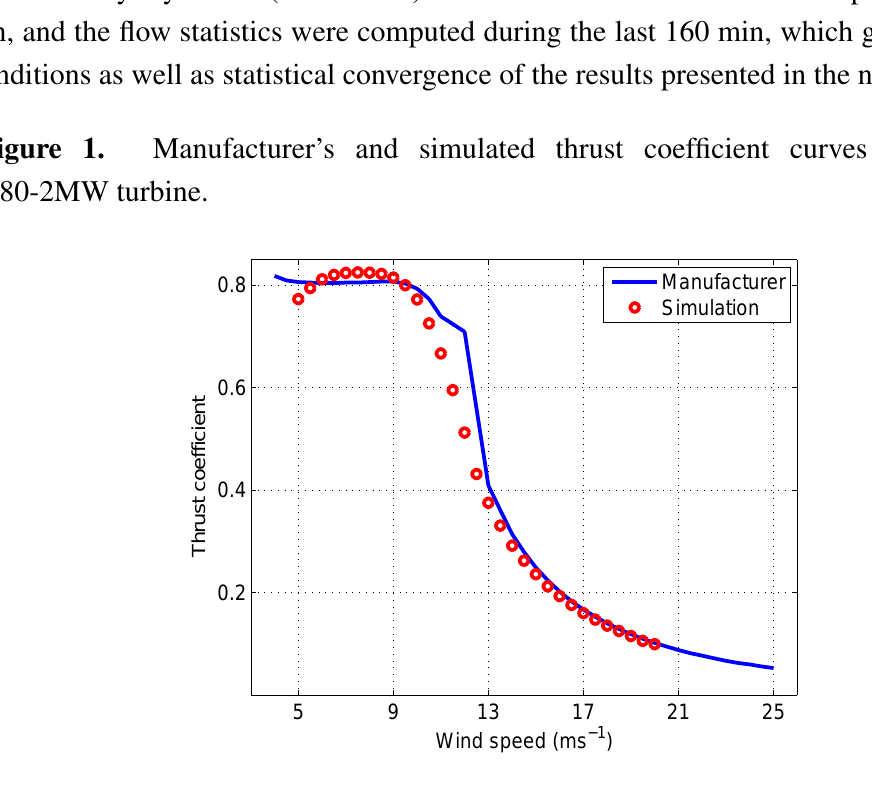
Table 2. Friction velocity and mean streamwise pressure gradient force for simulations of ABL over flat surfaces with four aerodynamic roughness